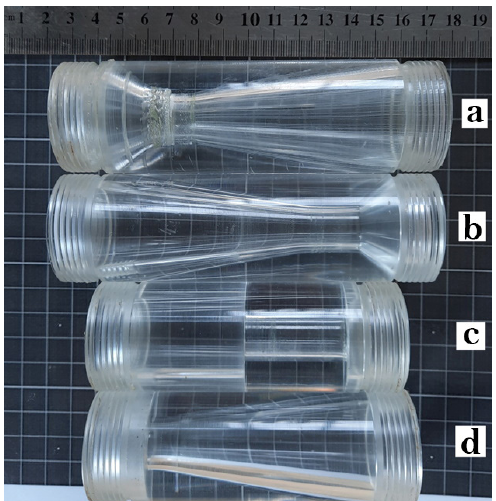
Figure 2. Test chambers (cavitators). Scale on the top is in mm. ( a ) venturi tube, ( b ) inverted venturi tube, ( c ) cylindrical nozzle, ( d ) diverging nozzle. The smallest inner flow section diameter for all test chambers was 12 mm, length 150 mm, and outer diameter 40 mm. More detailed geometry is shown in Figure 3. For each of the test chambers, critical values of the pressure drop for cavitation in- ception were experimentally determined, as well as the geometric characteristics of cavi- tation cavities at various pressure parameters.